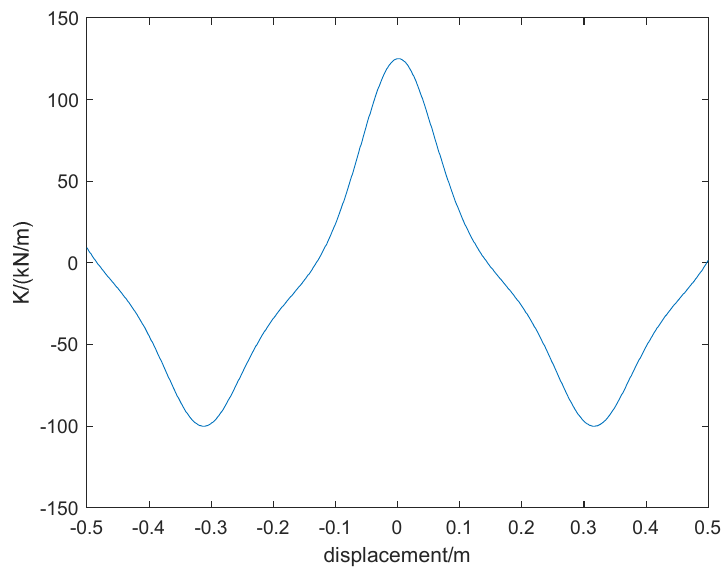
Figure 5. Relationship between and .